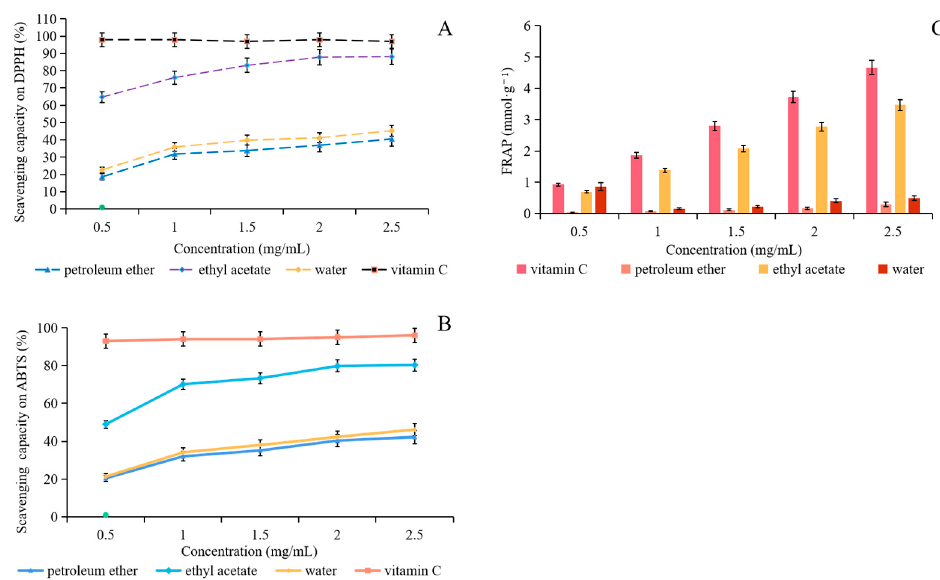
Figure 2. Effect of different extraction solvent on antioxidant capacity. ( A ) Scavenging capacity on DPPH radical, ( B ) scavenging capacity on ABTS radical, ( C ) ferric-ion-reducing capacity.